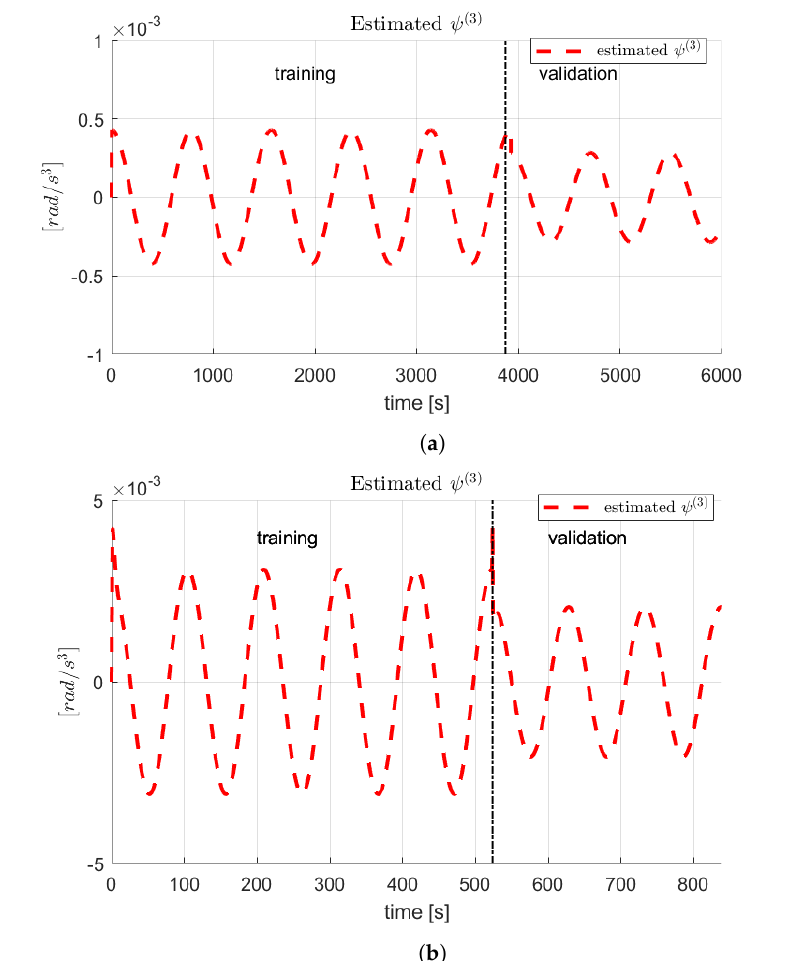
... ψ of the two vessels. The data on the left side of the black dotted line are Figure 7. Estimates of training samples and on the right side are validation samples. ( a ) Cargo vessel. ( b ) Patrol vessel. Table 4. Error of estimations and measurements or simulations for